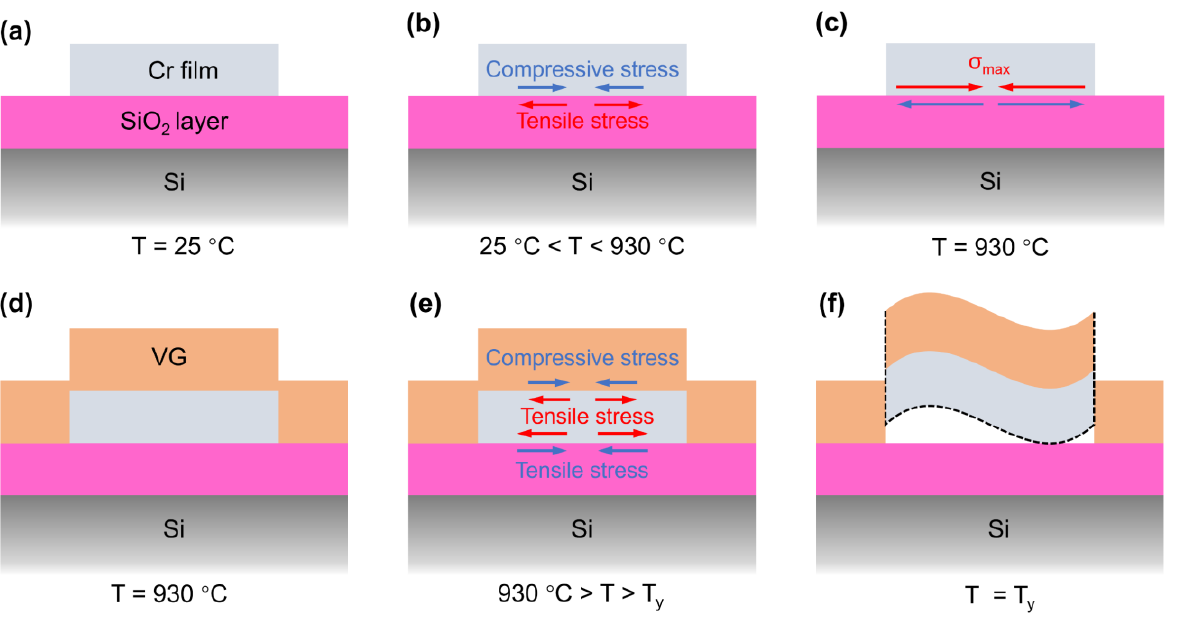
Figure 7. Schematic of patterned VG growth mechanism: ( a ) Before heating and growth of VG, there is almost no stress inside the SiO 2 /Si substrate with patterned Cr film. ( b ) During heating, the absolute values of the compressive stress (blue line) applied in the Cr film and the tensile stress (red line) applied in SiO 2 /Si increase with the increase in temperature. ( c ) The compressive stress in the Cr film reaches a maximum ( σ max = − 660 MPa) when the temperature rises to 930 °C. ( d ) During the VG growth period, the stresses in the sample are relaxed. ( e ) During cooling, tensile stress is applied in the Cr film, and compressive stress is applied in both the VG film and SiO 2 /Si, both of which increase with the decrease in temperature. ( f ) When the temperature drops to T y , VG/Cr cracks and warps, and then automatically separates from the substrate.